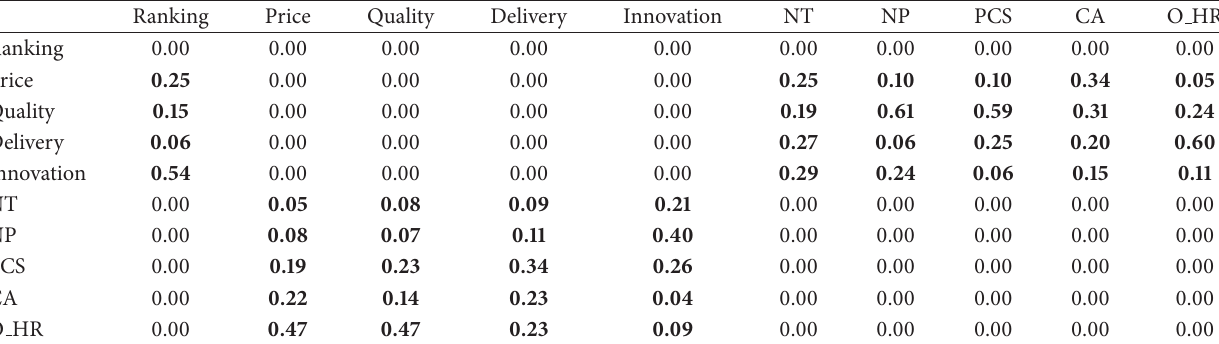
Table 7: Normalized supermatrix of decision agent 4.